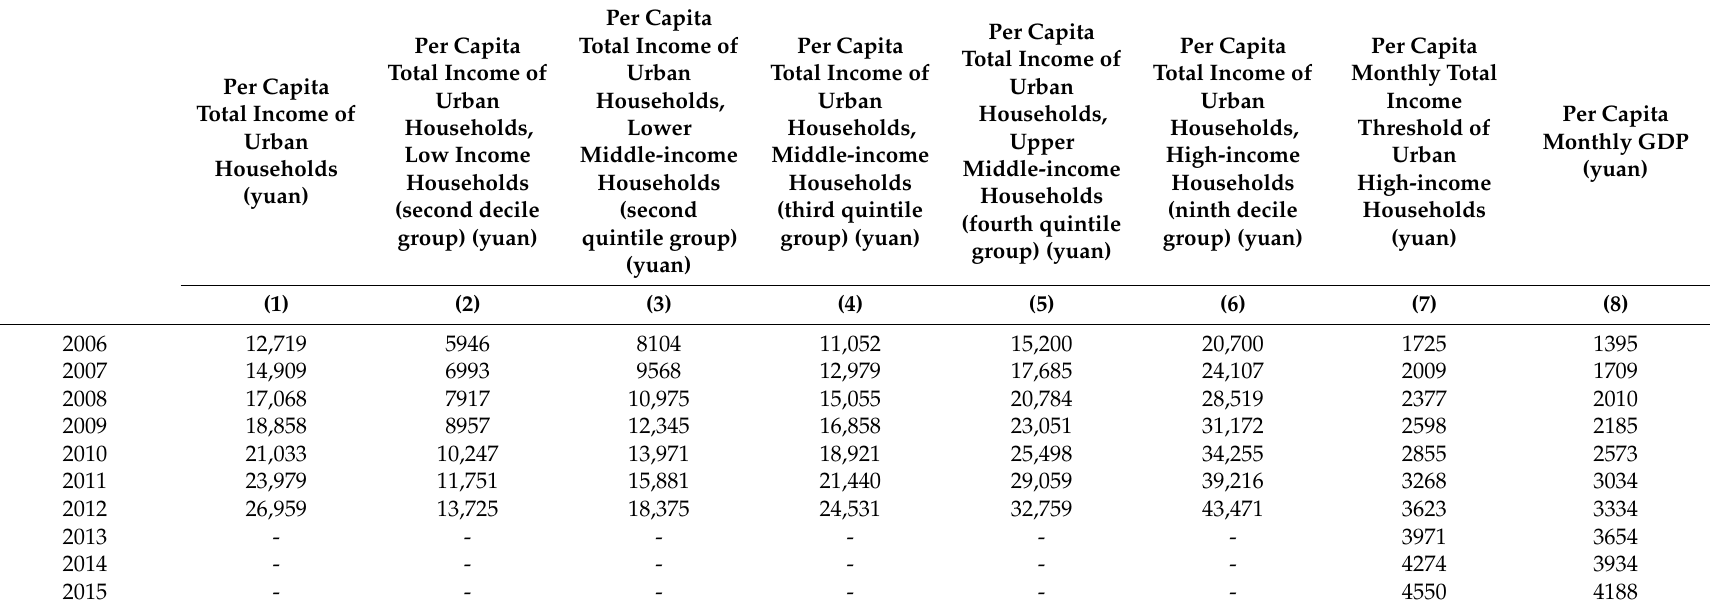
Table A2. Per capita income classification of urban households in China,